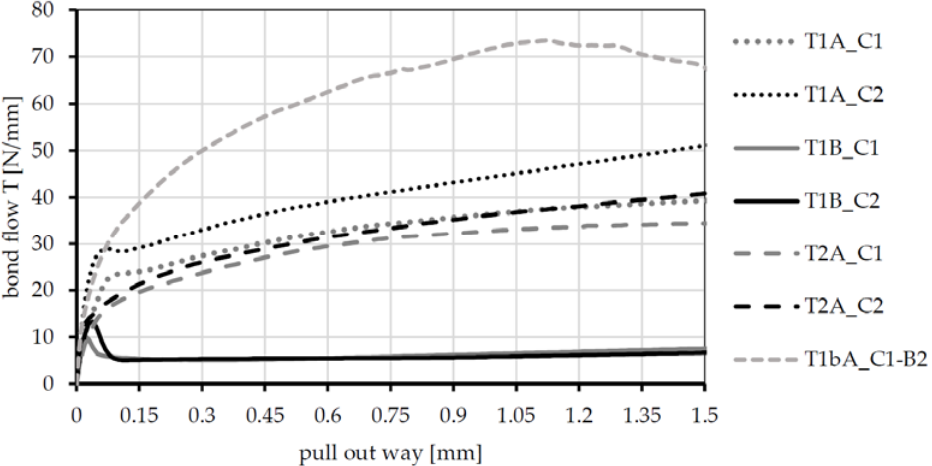
Figure 9. Bond-flow (T)—pull-out way-curves of the four textiles embedded in concrete C1 and C2 carried out on specimens with a width of b c = 60 mm, with mean value curves of six single value curves each (exception T1bA: one representative curve).